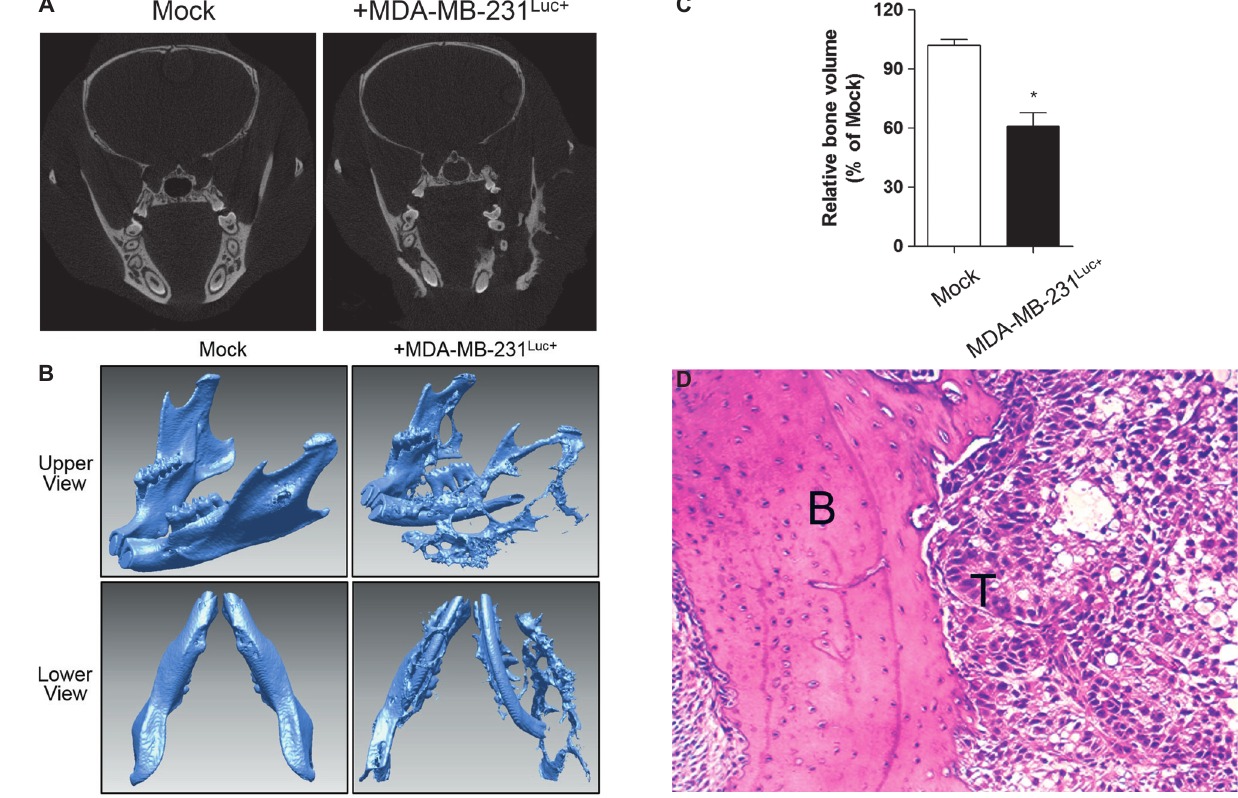
Figure 2- Mandible bone analysis. Radiographic images of mandibles in mice were scanned by m CT at 6 weeks. The osteolytic lesions were analyzed on vertical projection (slice) (A); and 3-D reconstruction images (B; upper and lower view each). The bone volume was determined from processed images shown in 3-D images (B); with the same given diameter (C). Data are expressed as the mean±standard error (SEM). * P <0.01 versus Mock group. Hematoxylin & eosin staining around the mandibular region was performed and the tumor-induced osteolytic site was observed. (original magnification ×100) (B; bone, T; tumor)